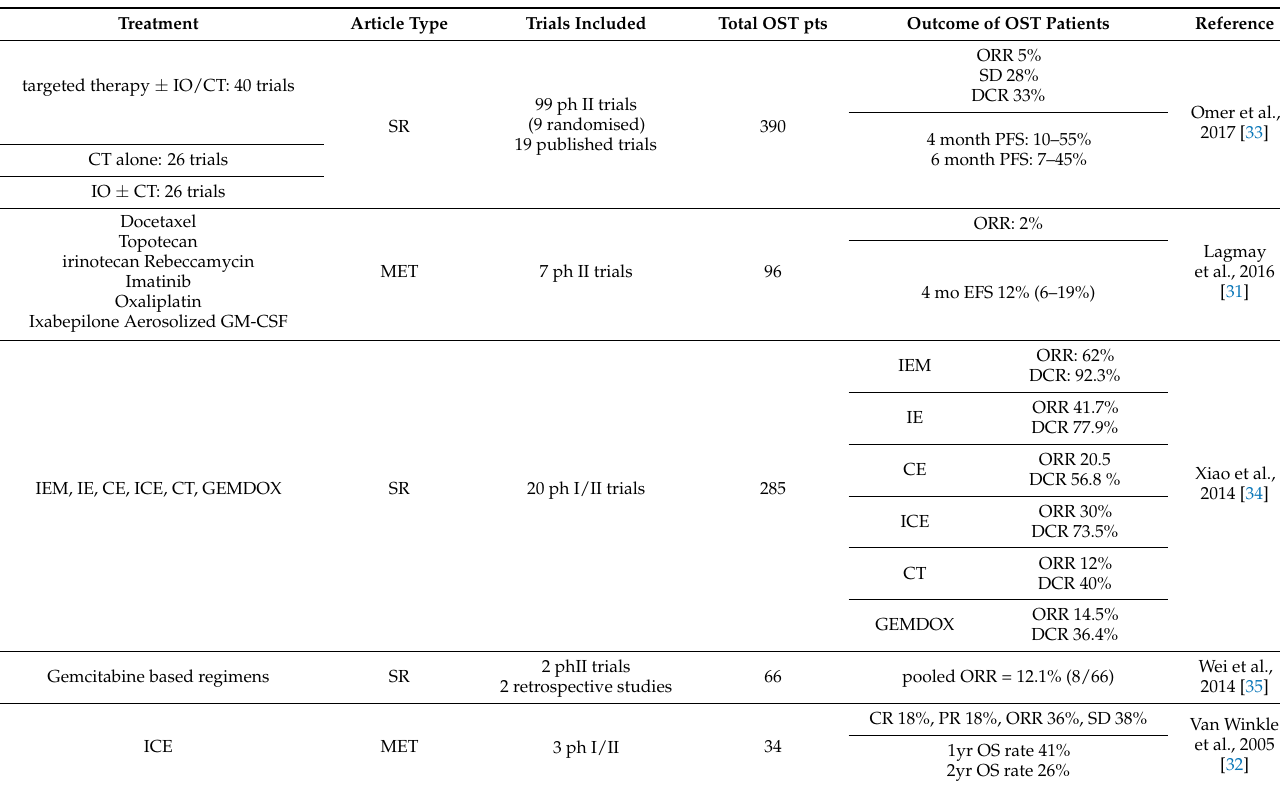
Table 6. Metanalyses (MET)/systematic reviews (SR) (five